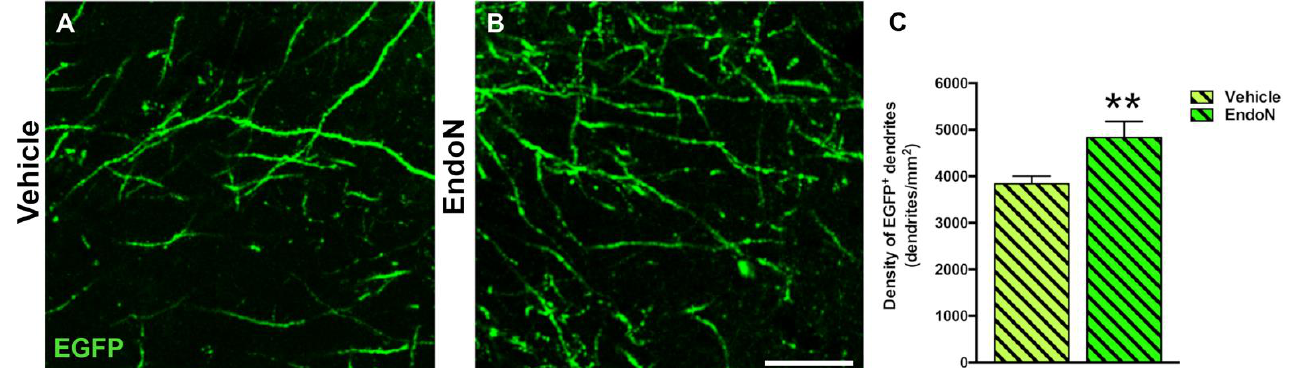
Figure 6. Confocal analysis of the density of EGFP + dendrites in the PCX layer I. (A,B) Single confocal planes showing dendritic processes in the vehicle ( A ) and Endo-N ( B ) hemispheres. ( C ) Graph showing a higher density of dendrites in the Endo-N versus the vehicle hemisphere. Asterisks indicate statistically significant differences between hemispheres (Vehicle vs. Endo- N) after paired Student’s t- test. (** p < 0.01). Scale bar: 10 µm.